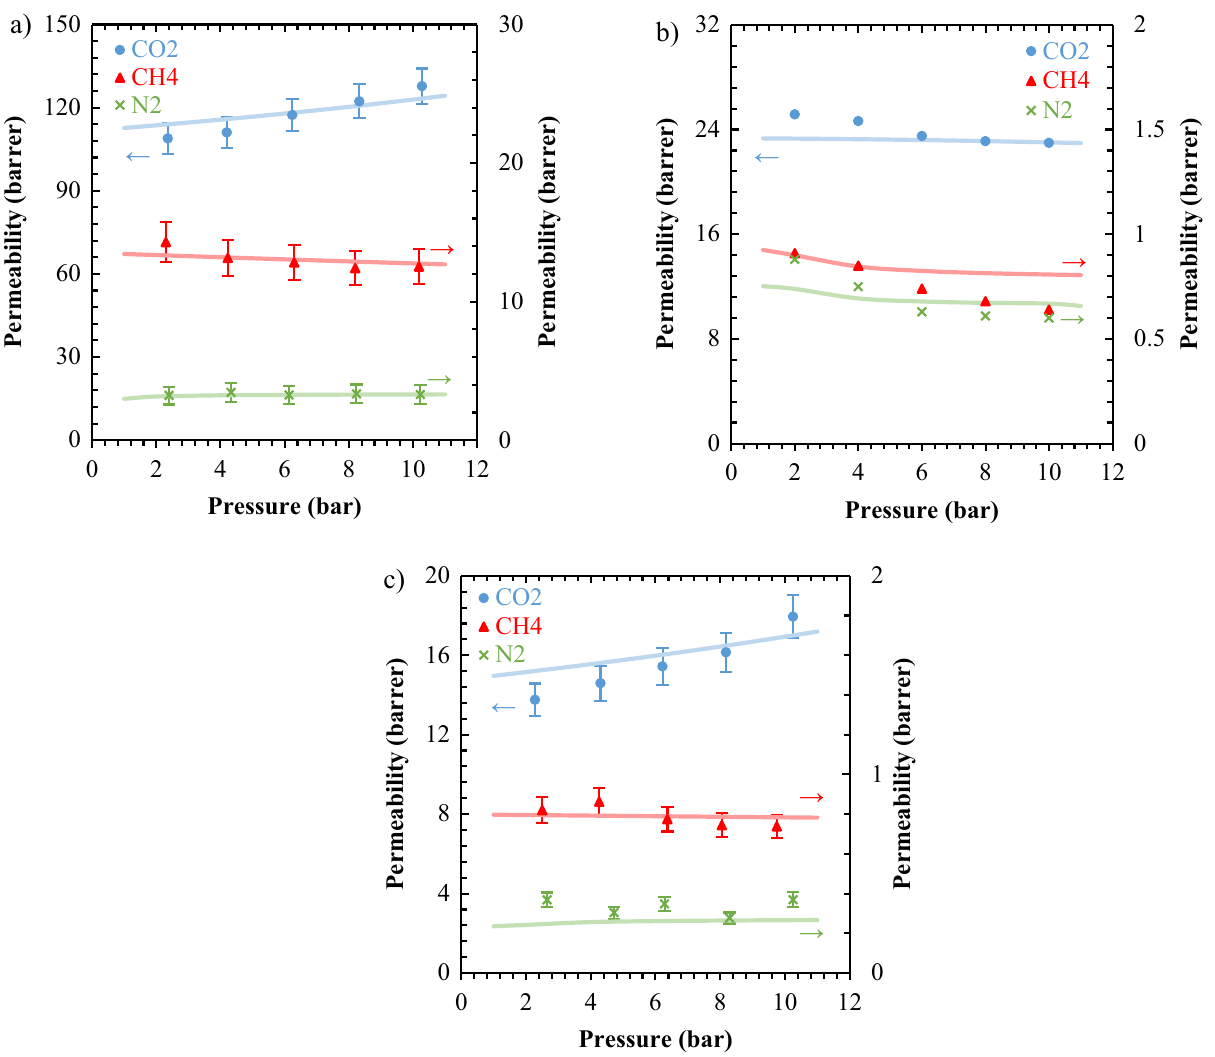
Figure 7. The experimental (dots) and theoretical (lines) gas permeabilities as a function of the operating pressure: ( a ) TPU-1, ( b ) TPU-2 35 , and ( c )